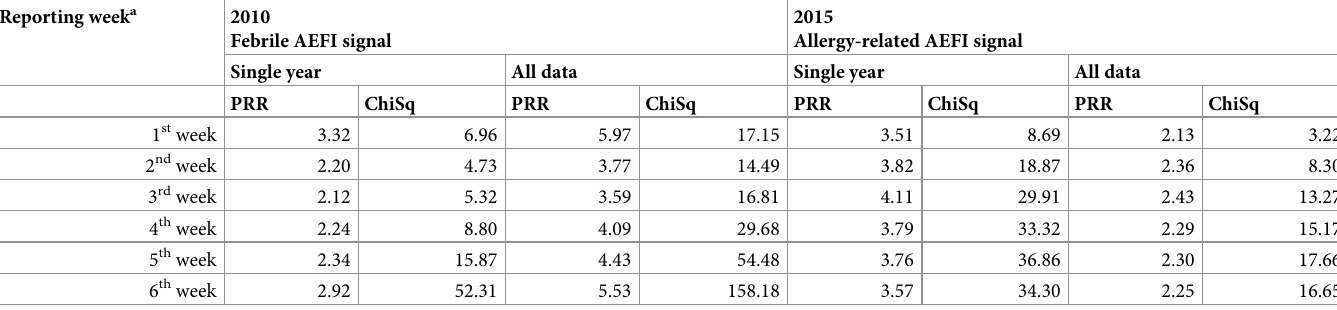
Table 3. Comparison of results using single year data or all previous year data for 2010 and 2015 signal detection a . Reporting week